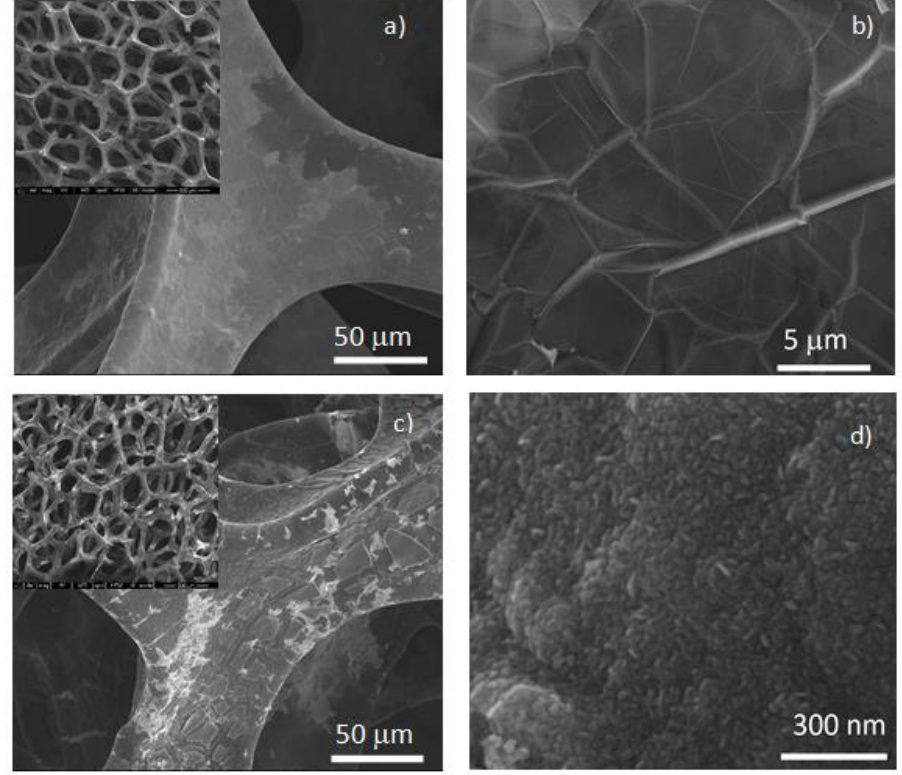
Figure 2. Morphological characterization of ( a , b ) 3D-GF/Ni and ( c , d ) TiO 2 /3D-GF/Ni hybrid reviling the uniformity of the graphene network (insets) with graphene’s microscopic wrinkled and corrugated morphology, and the TiO 2 film entirely coating the 3D-GF/Ni skeleton with the flower-like morphology.